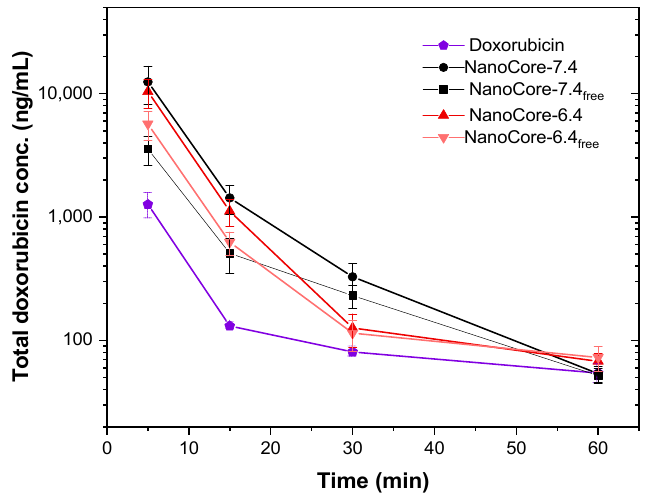
Figure 5. Pharmacokinetic profiles (1 h) for the free and the total doxorubicin concentration following intravenous administration of NanoCore-7.4 (red) and NanoCore-6.4 (grey) in 1% poloxamer 188 as well as a solution of doxorubicin hydrochloride in water (violet) at a dose of 5 mg/kg ( n = 6, mean ± SD).